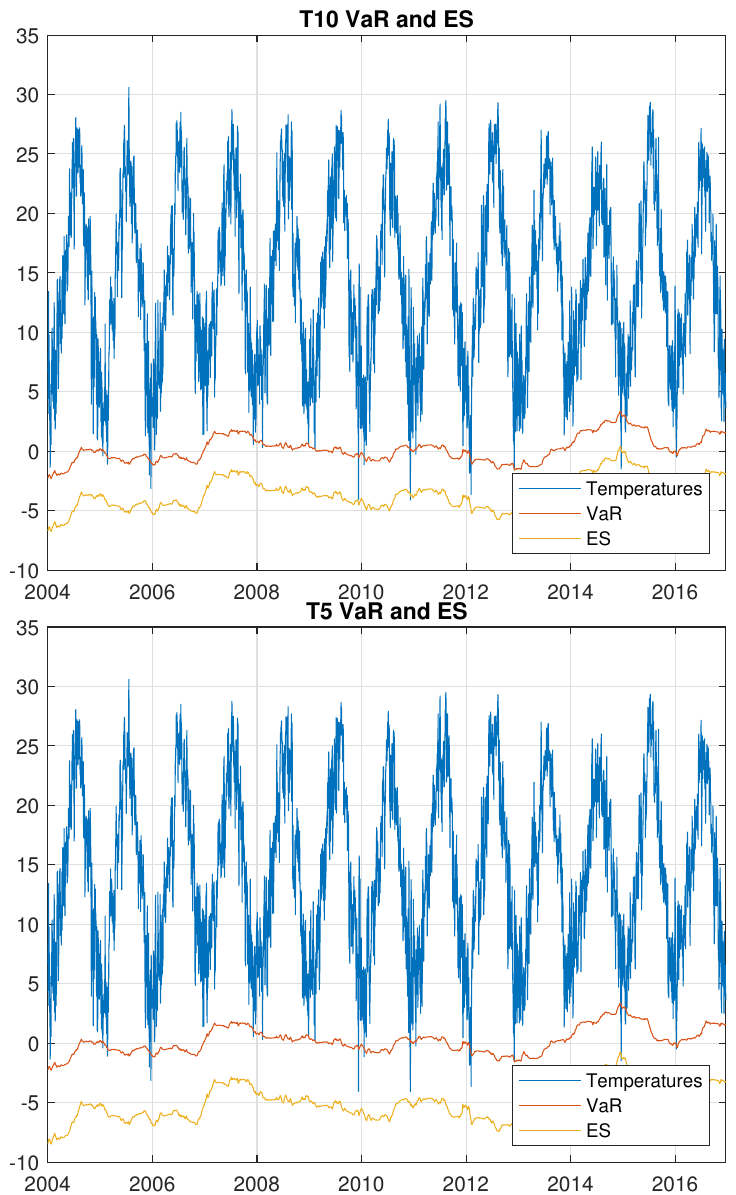
Figure 7. Daily average temperature, VaR and ES estimated with the T10 and T5